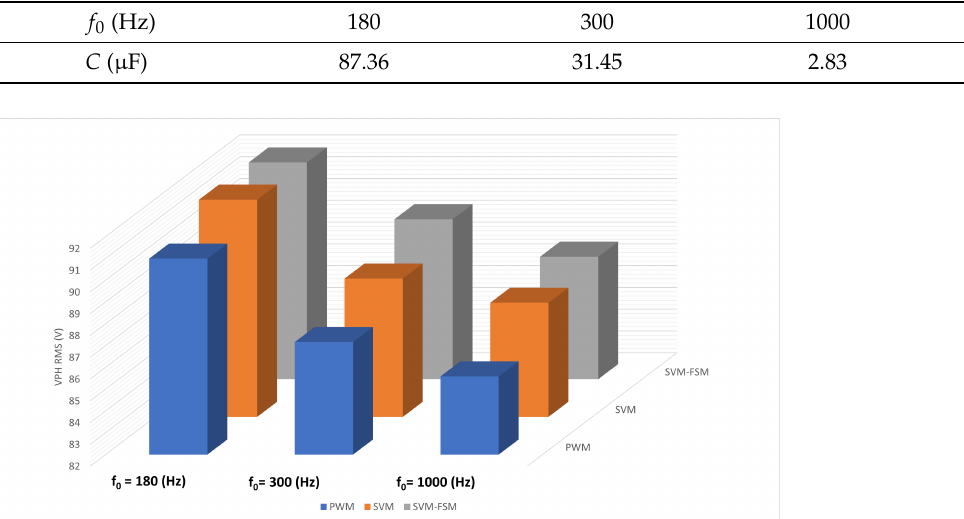
Table 3. Capacitor values depending on the cut-off frequency.